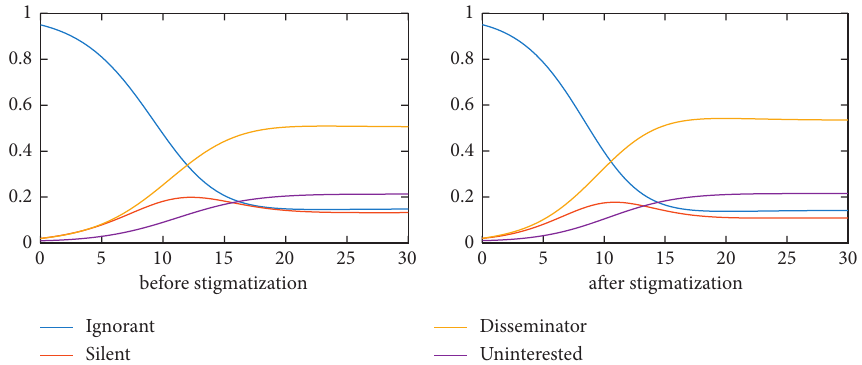
Figure 6: Simulation of the system before and after